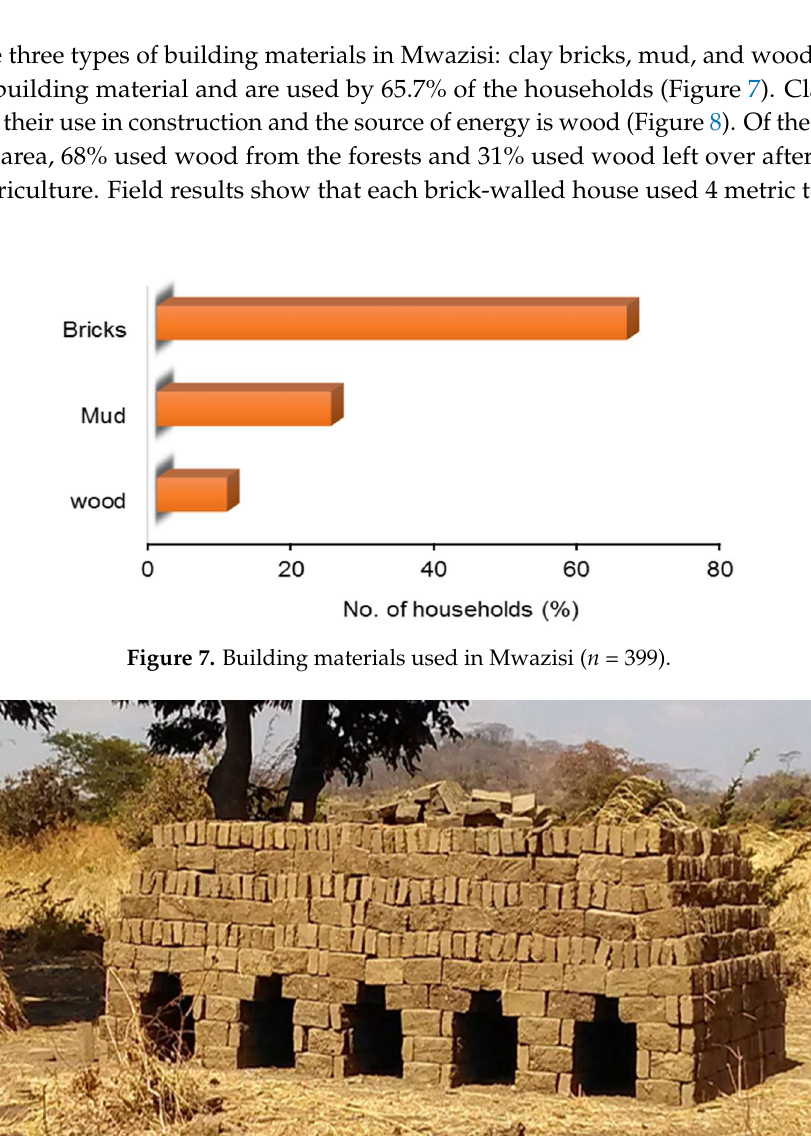
Figure 8. Clay bricks being packed for burning (Photo by Teiji Watanabe, 7 August 2017).